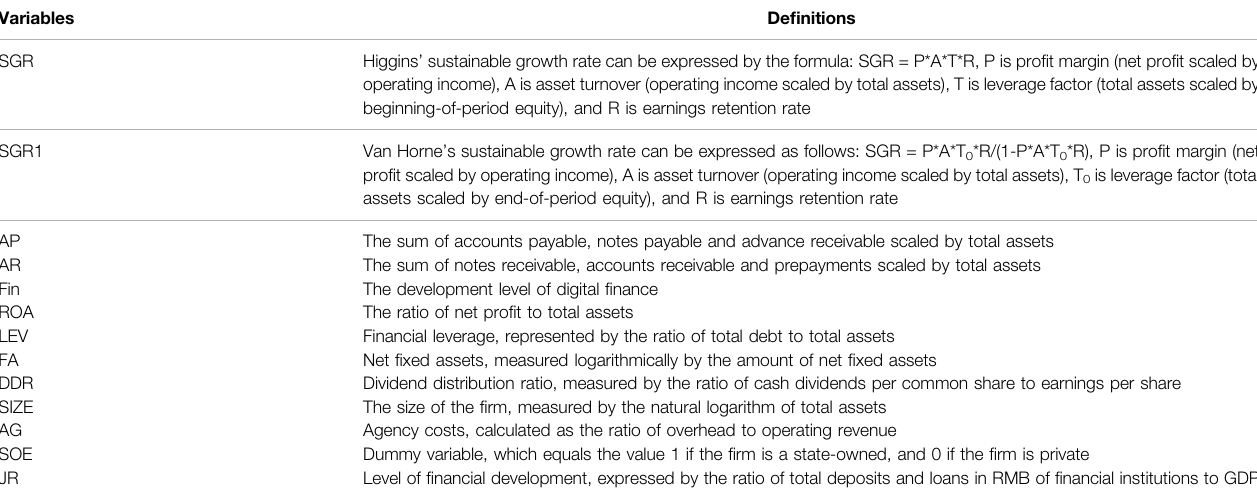
TABLE 1 | The de fi nitions of the main variables.